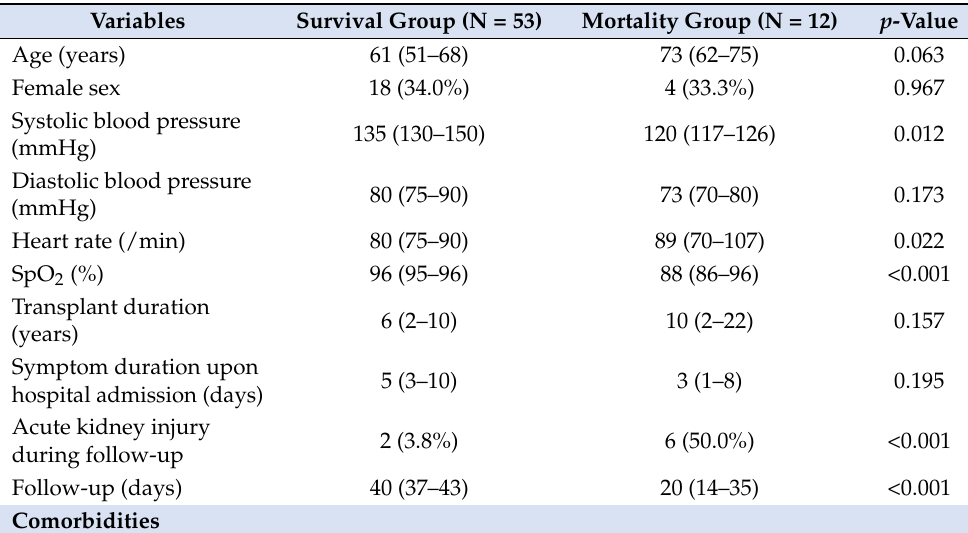
Figure 1. Overview of the 30-day post-discharge mortality in the study sample. Table 2. Baseline characteristics of the study sample.